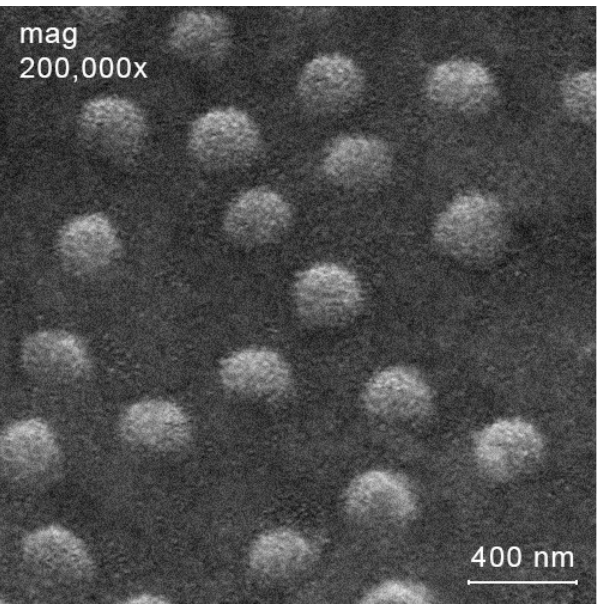
Figure 1. SEM image of POX-2. Table 1. Characteristics of the obtained nanoparticles.